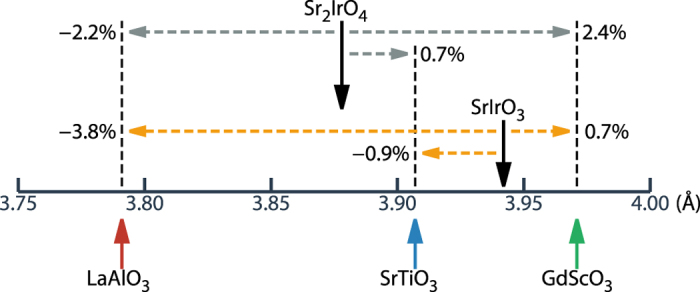
Comparison of in-plane lattice parameter of Sr2IrO4 (214) and SrIrO3 (113) with various oxide substrates.LaAlO3 (LAO) and GdScO3 (GSO) substrates yield compressive and tensile strains, respectively, while the lattice mismatch would be minor for SrTiO3 (STO). In-plane lattices parameters for 214 and 113 systems are from refs 46,47, respectively, where orthorhombic 113 system is converted to corresponding pseudo-cubic phase.